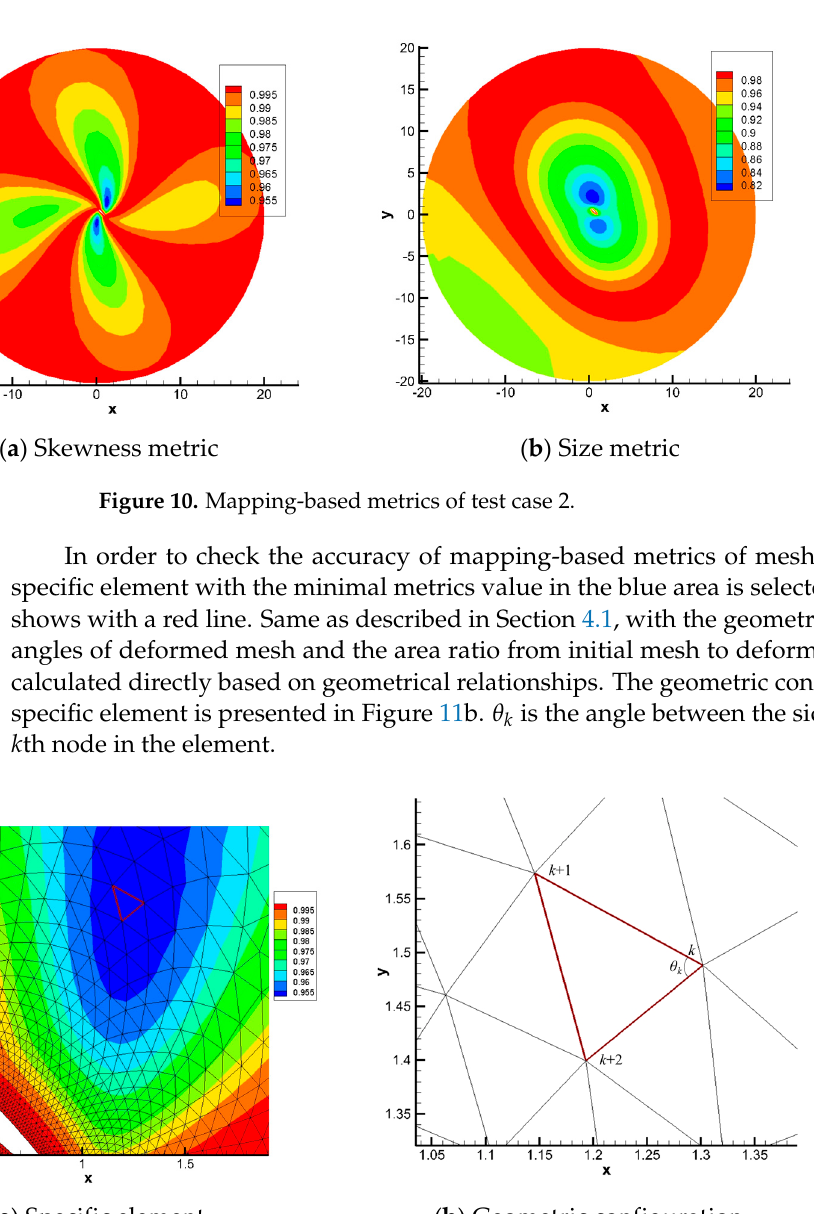
Figure 9. Deformed mesh around the airfoil.